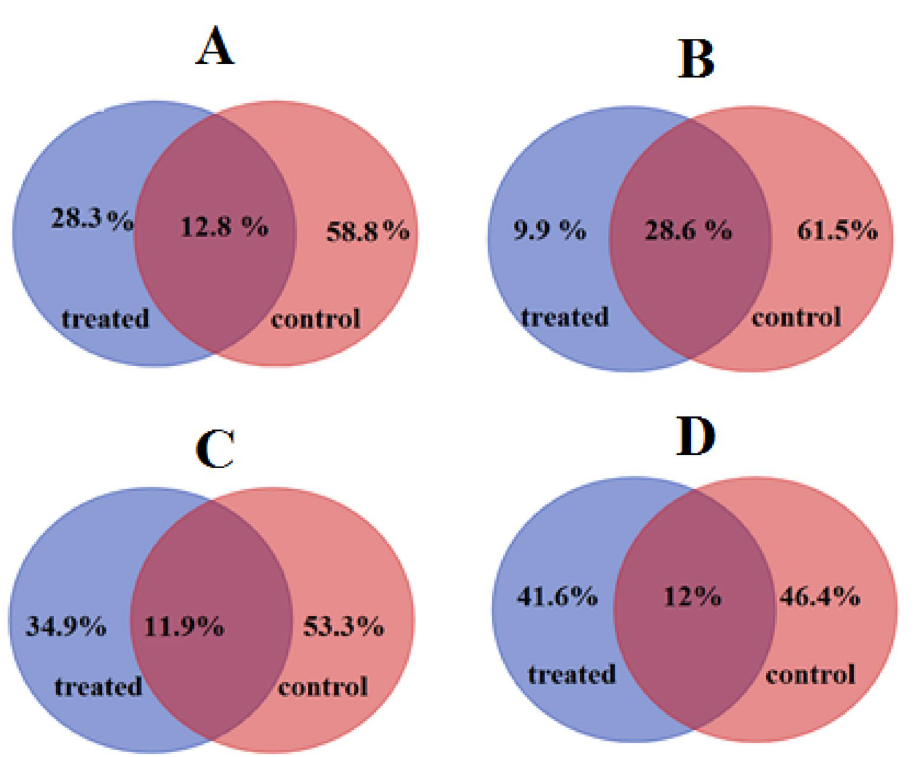
Figure 3. Comparison of hub genes in control and hypersalinity conditions in Green ( A ), Blue ( B ), Brown ( C ), and Yellow ( D ) module as non-preserved modules. Details of identified hub genes for each module can be found in Supplementary File